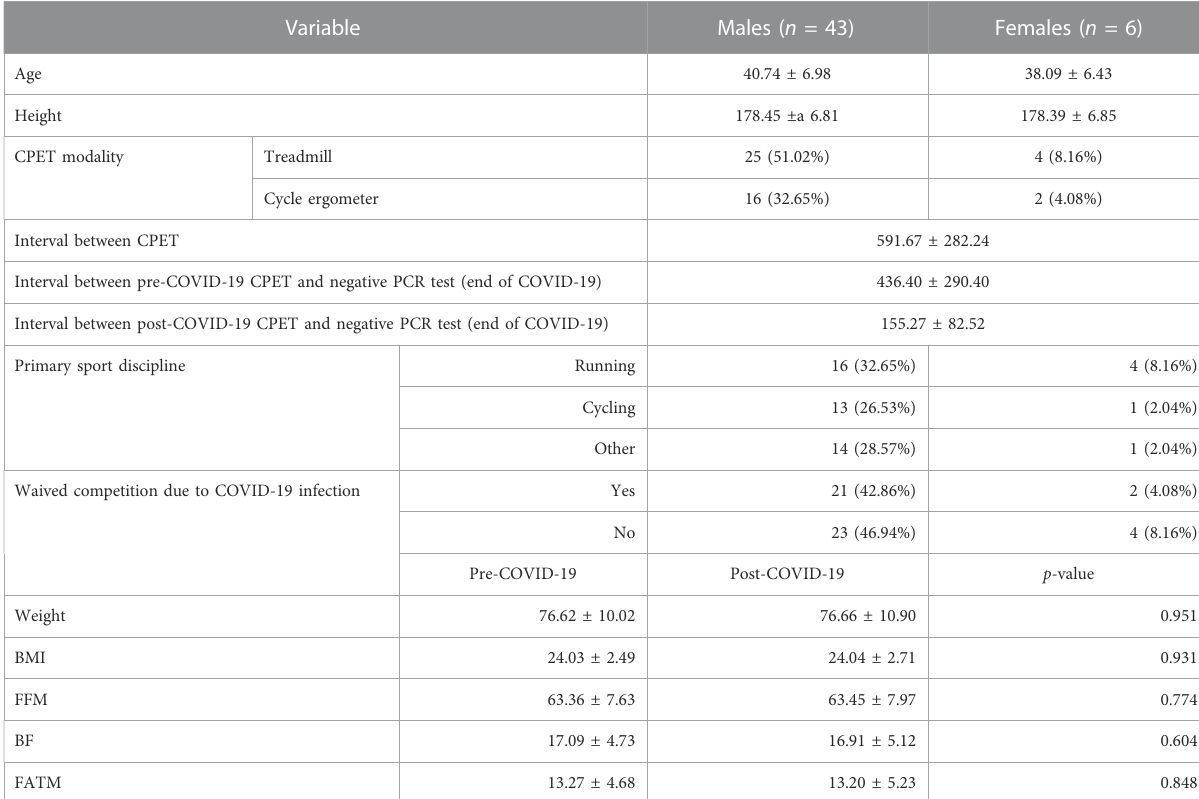
TABLE 1 Participants